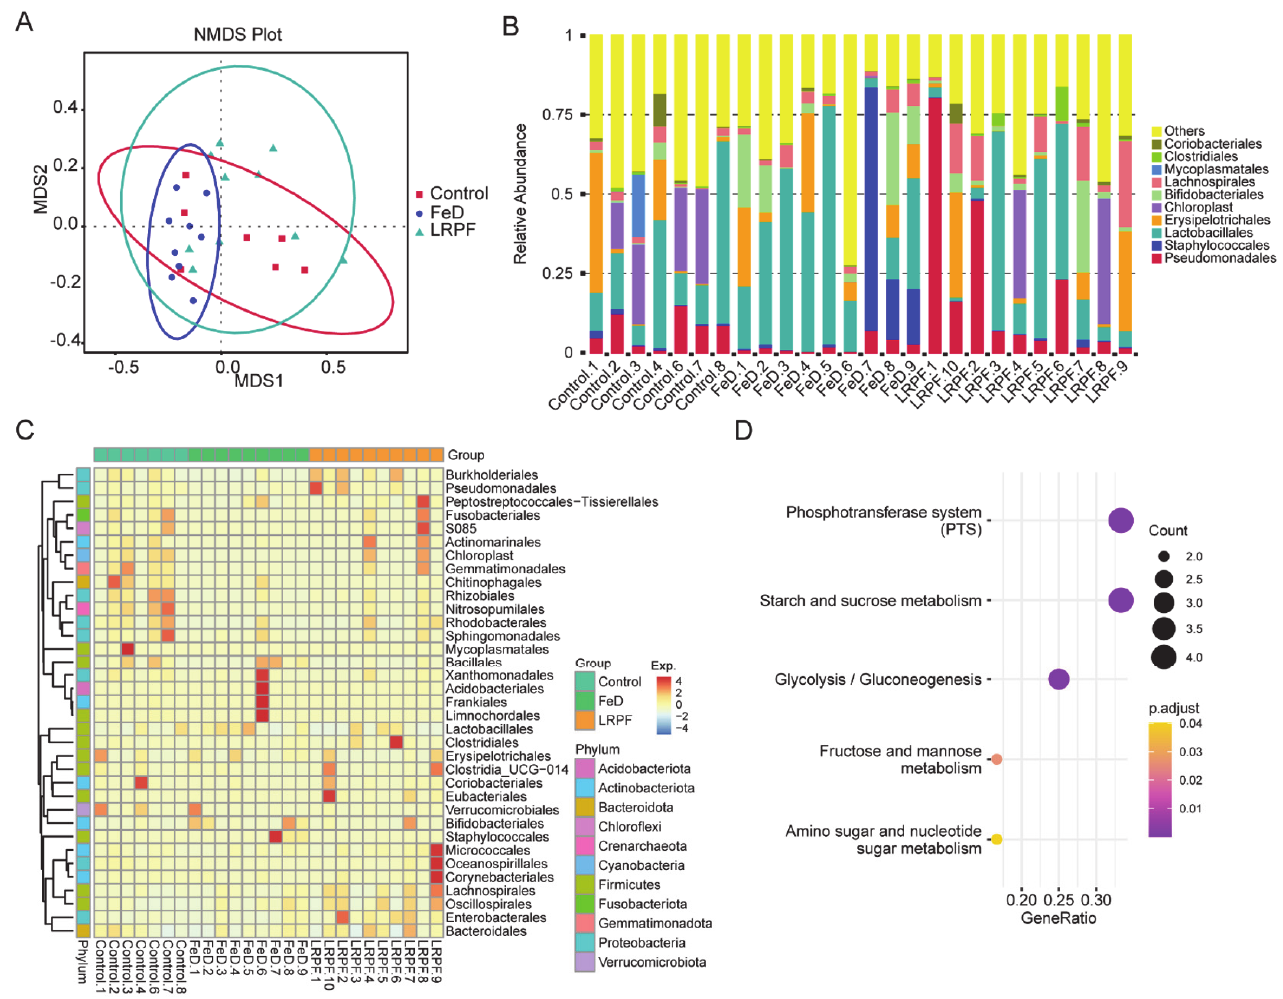
Figure 5. Effects of LRPF on the intestinal flora of mice with iron-deficiency anemia. ( A ) Nonmetric multidimensional scaling (NMDS) plot showing the relationship between samples. The red square means the control group, the blue dot means the iron deficiency (FeD) group, and the green triangle means the LRPF group. ( B ) The relative abundance of the top 10 microbiotas at the order level. Different colors mean different microbiotas. ( C ) The heat map showing the top 35 microbiotas at the order level. ( D ) The dot plot showing the top 5 KEGG signaling pathways of the top microbiotas.